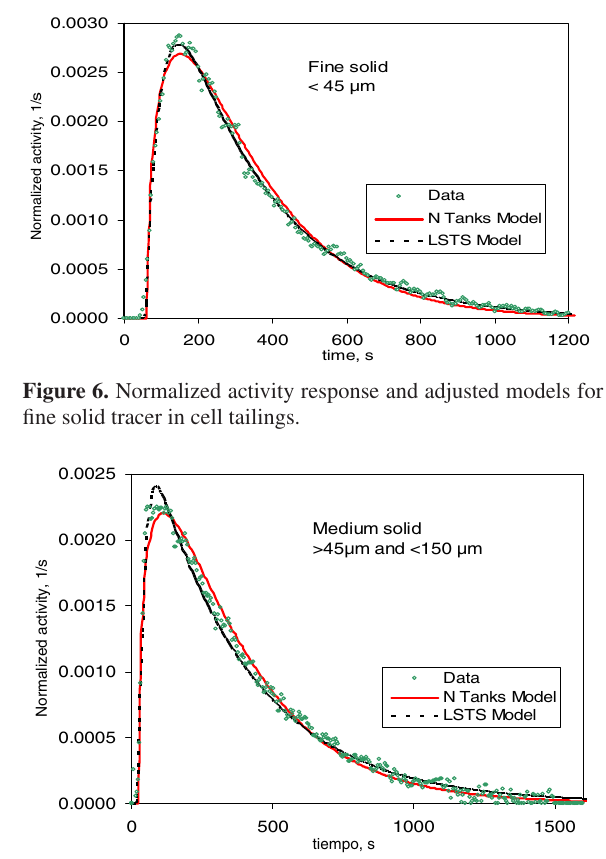
Figure 7. Normalized activity response and adjusted models for medium solid tracer in cell tailings.